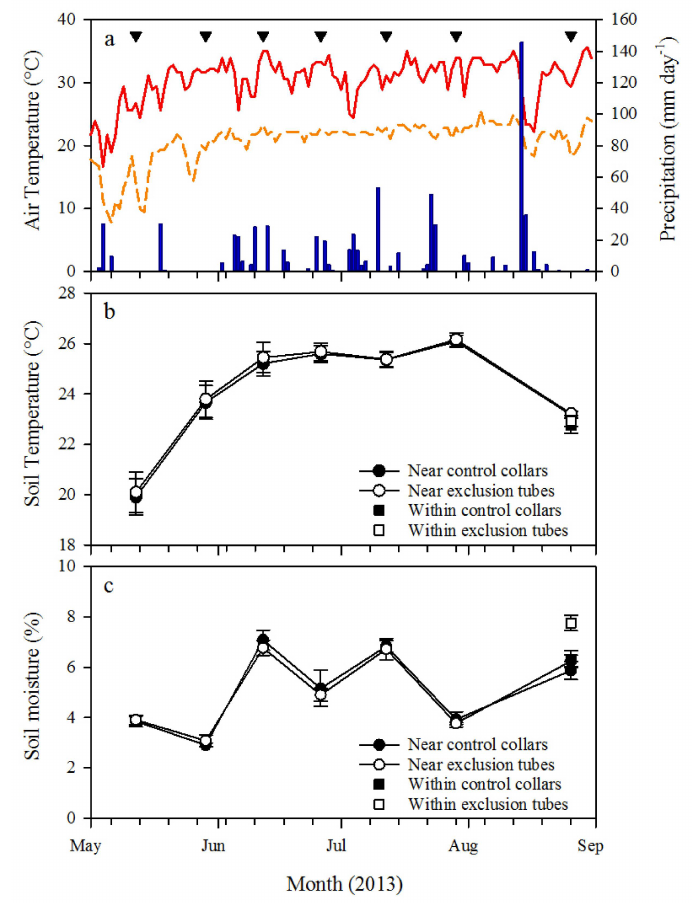
Figure 2. ( a ) Daily maximum (red solid line) and minimum (orange dashed line) air temperature and precipitation (blue bars) for Columbus Metropolitan Airport Weather Station [22]. Triangles indicate soil respiration sampling dates. ( b ) Soil temperature and ( c ) soil moisture by sampling date and treatment measured in three 26-year-old longleaf pine ( Pinus palustris Mill.) stands. Note: Error bars are ˘ 1 SE (standard error). Initial soil temperature and moisture measurements were pooled from 10 and 15 May